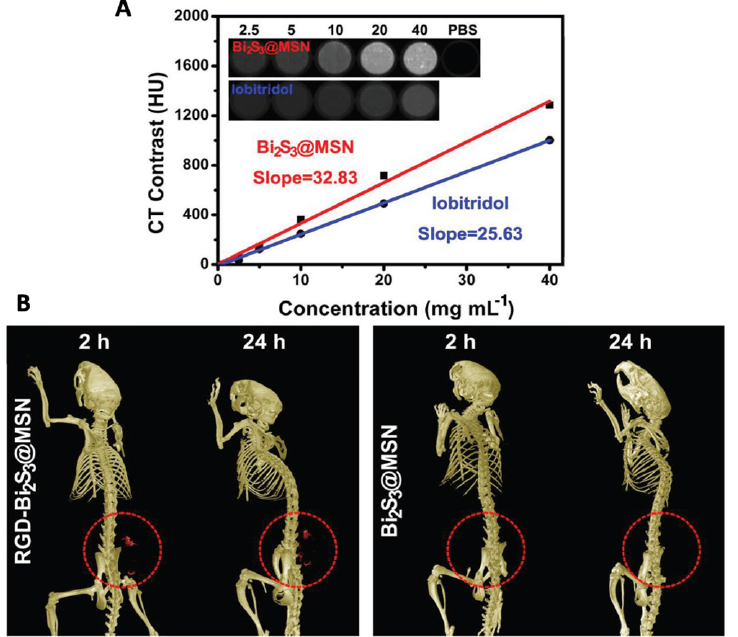
Figure 2. ( A ) In vitro CT performance of Bi 2 S 3 @MSNs in comparison with commercially available iobitridol. Inset: Suspensions of Bi 2 S 3 @MSNs and iobitridol at different concentrations showing CT contrast. ( B ) Representative CT images of UMR-106 tumor-bearing nude mice showing contrast provided by RGD–Bi 2 S 3 @MSN and Bi 2 S 3 @MSN captured 2 and 24 h post-treatment. The red circle high- lights the tumor site. Reprinted with permission from Ref. [35]. Copyright © 2023 Wiley.